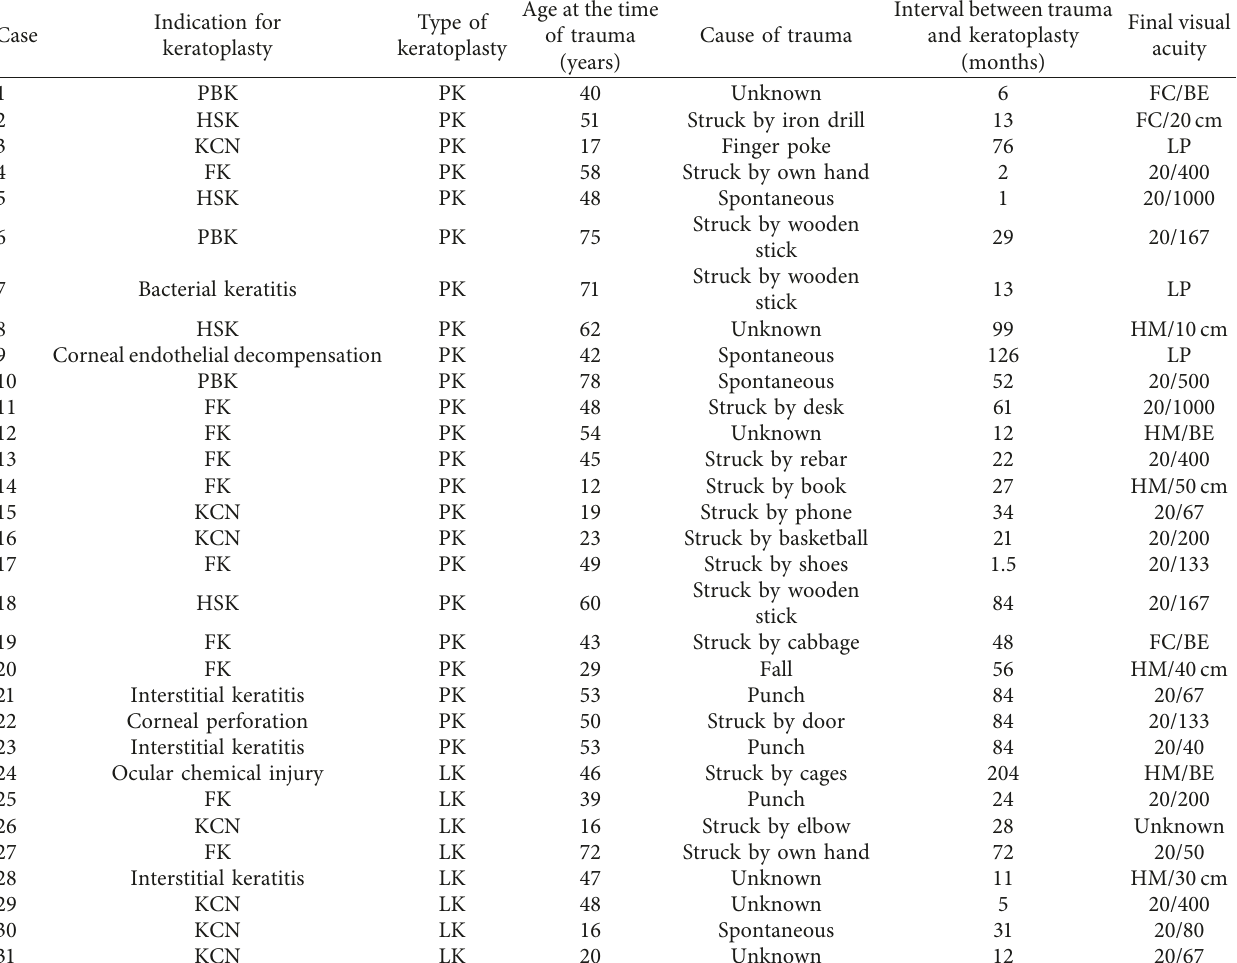
Table 1: Characteristics of wound dehiscence following